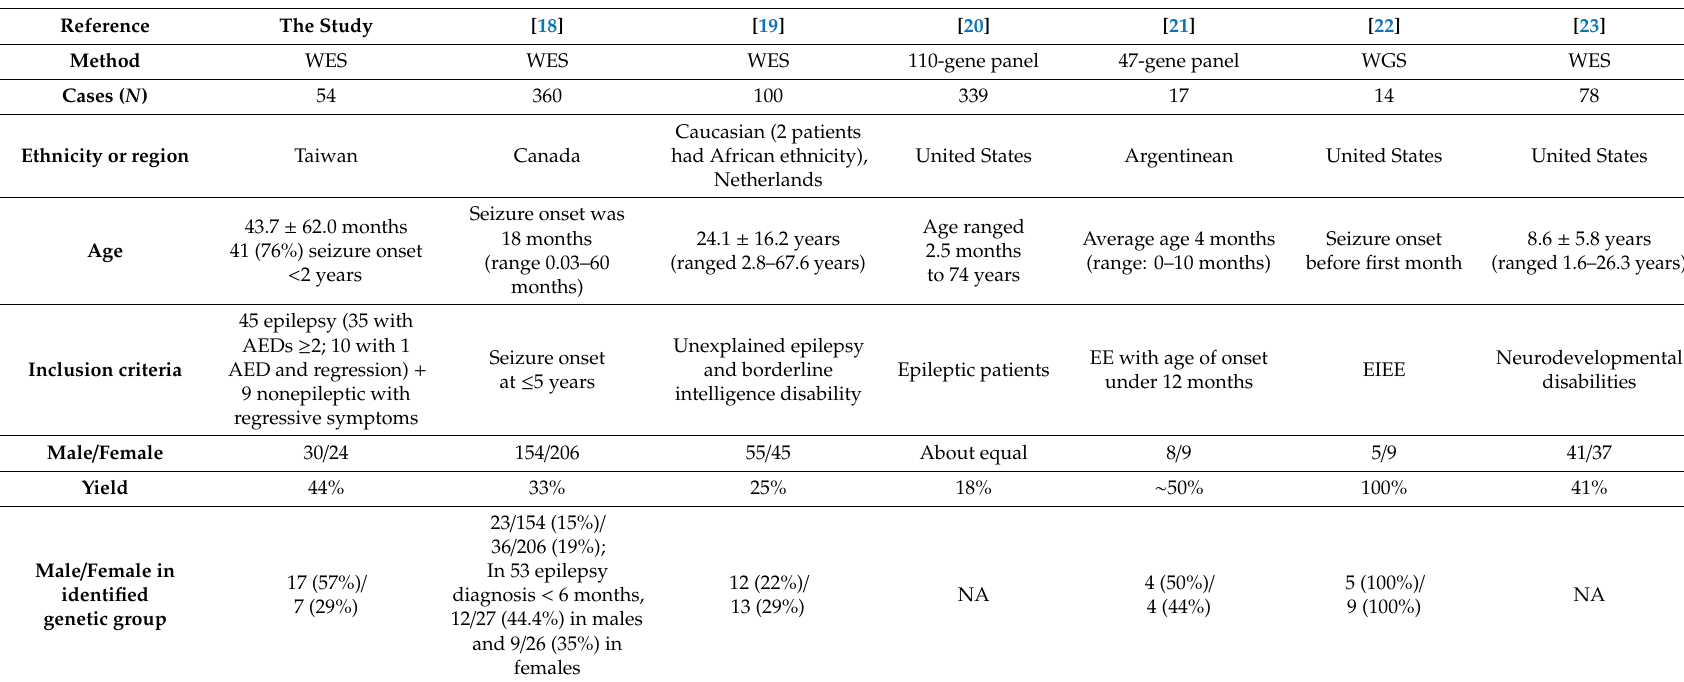
Table 4. Diagnostic yield from di ff erent methods to identify genetic